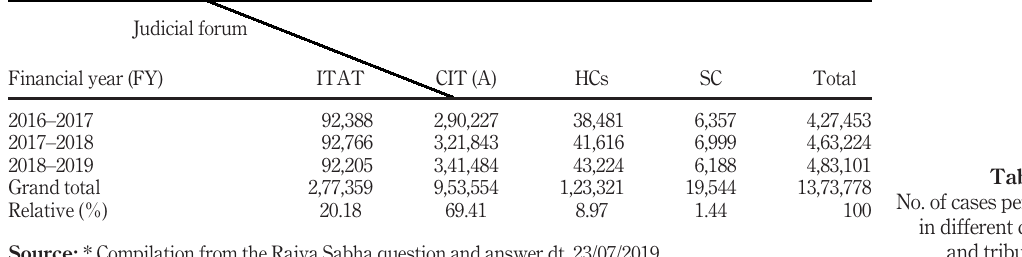
Table 1. No. of cases